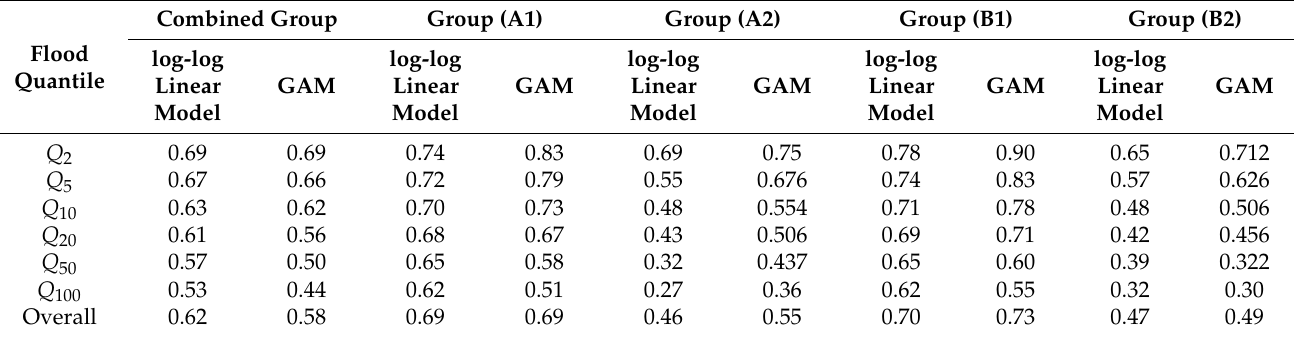
Table 4. R 2 values of the GAM and log-log linear models for 10 cases.